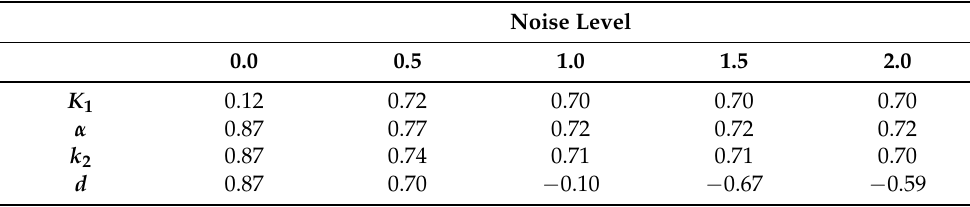
Table A2. Wilcoxon’s effect sizes of the relative error difference between the overlapping and adjacent framing strategies for each of the 1TCM kinetic parameters and each noise level. Negative values correspond to an increase in the absolute error for the overlapping framing with regard to the adjacent framing.